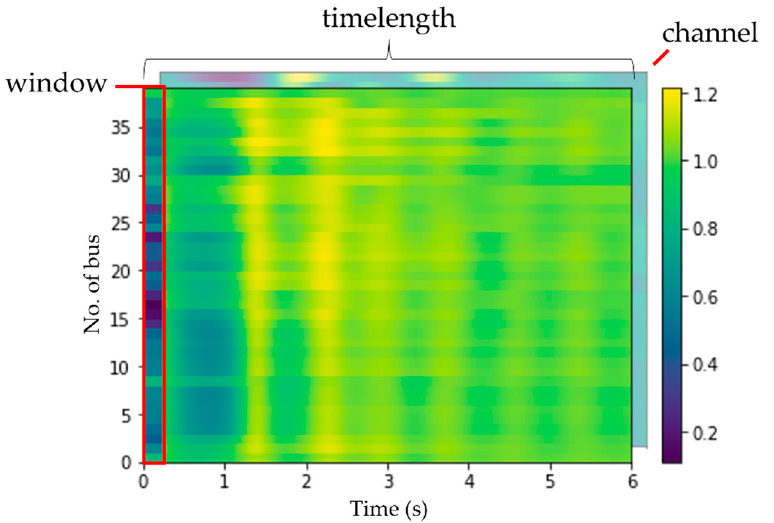
Figure 3. Proposed CNN-LSTM method architecture [30].